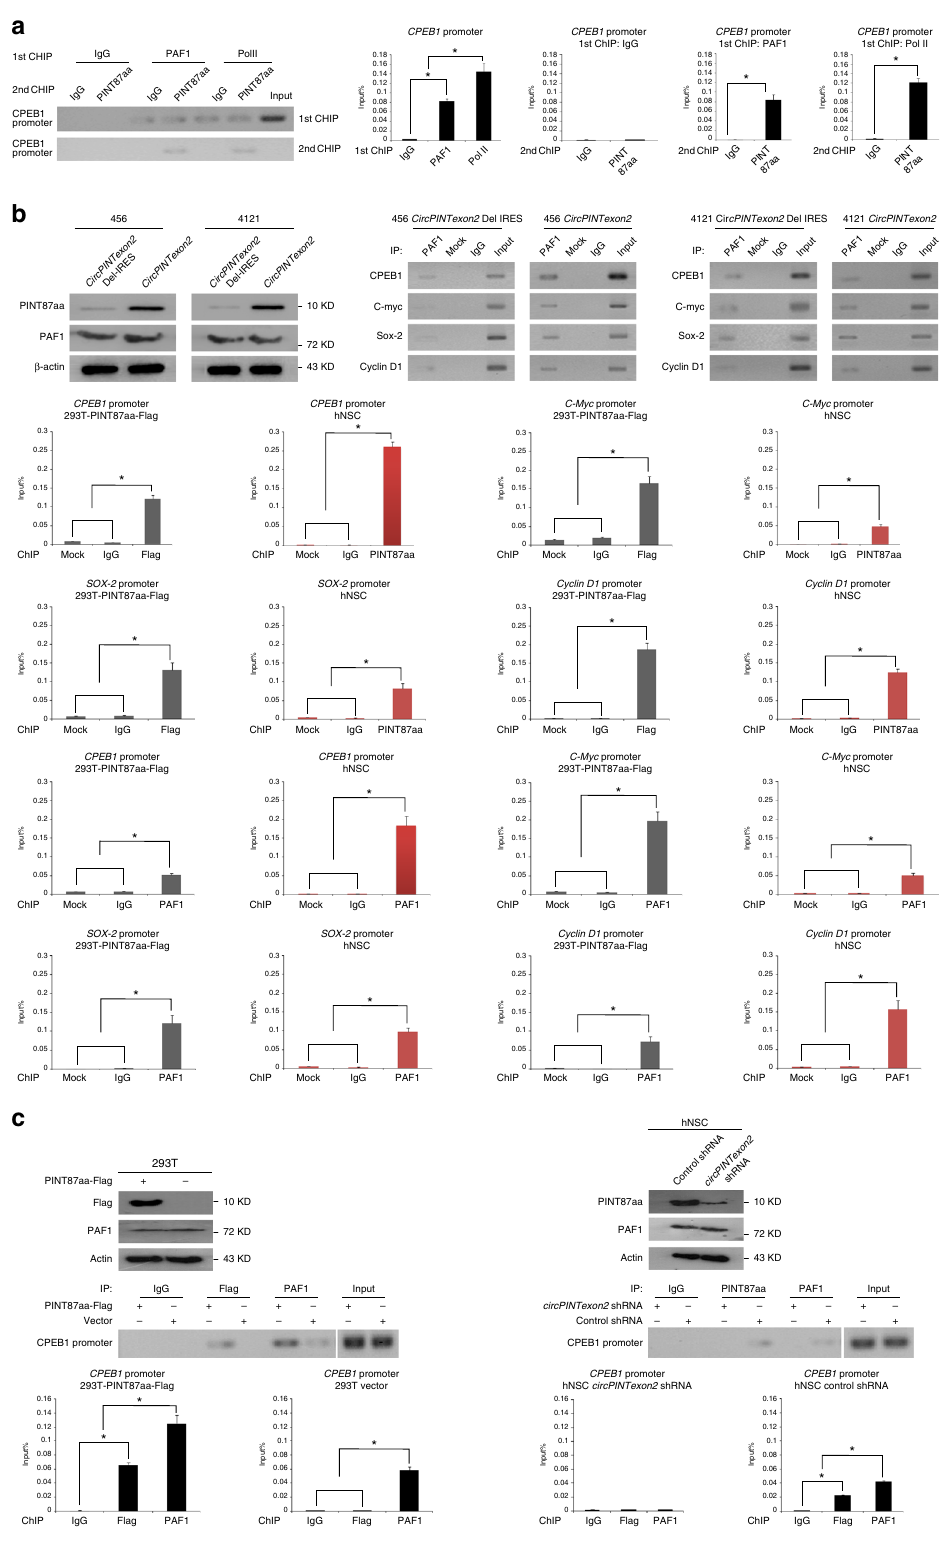
Fig. 7 PINT87aa decides the localization of PAF1 complex on target genes promoter. a 2nd ChIP assay was used to determine the co-occupation of PAF1 complex/PINT87aa in CPEB1 's promoter region by using RT-PCR or q-PCR. At least three independent experiments were performed. b ChIP assay was performed in circPINTexon2 stably overexpressed 456 and 4121 cells by using indicated antibodies. PCR products of indicated genes ’ promoter were analyzed by using RT-PCR or q-PCR. c PINT87aa was overexpressed or knocked-down in 293T or hNSC cells by using indicated plasmid or shRNA, respectively. ChIP assay was performed by using indicated antibodies and PCR products of CPEB1 promoter region were analyzed by using RT-PCR or q- PCR. b , c At least three independent experiments were